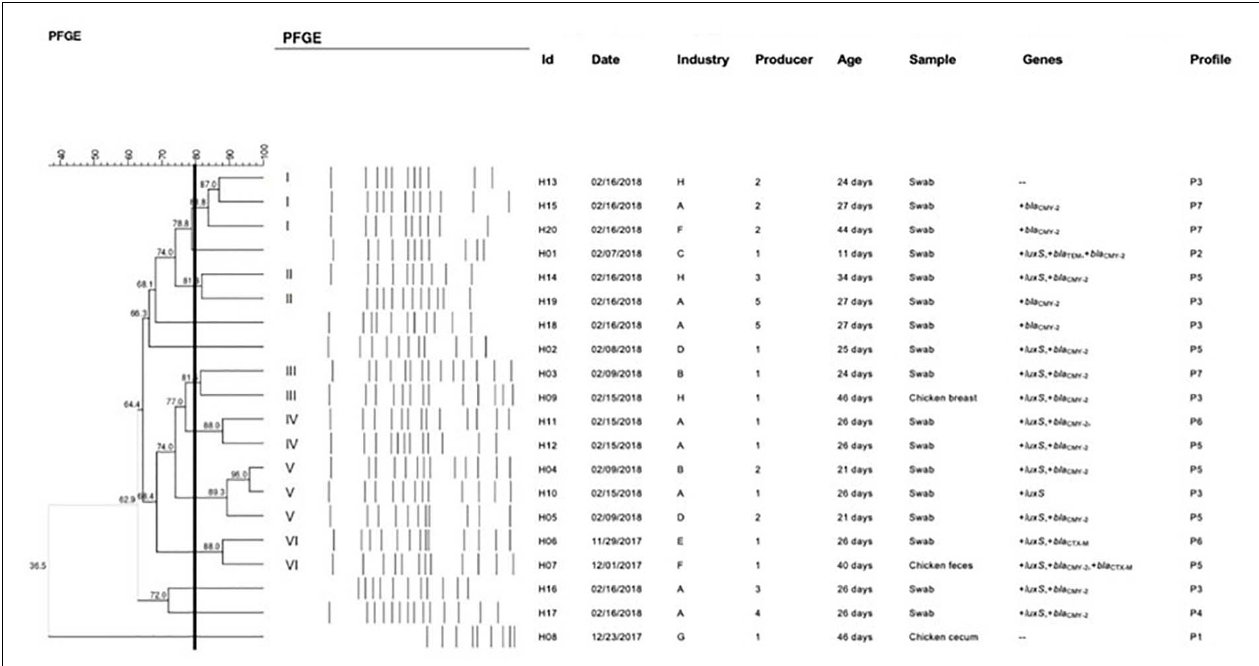
FIGURE 1 | Comparative dendrogram of 20 S H strains, constructed from PFGE results considering the isolation site, date of collection, and the presence or absence of specific genes and antimicrobial resistance, using the Dice similarity coefficient with 1.5% tolerance and UPGMA method with 0.80% optimization. I-VI, pulsotypes; Id, Identification. Genes: only those that showed differences between the strains. Profile: antimicrobial resistance profile (P1-P7; Table 1